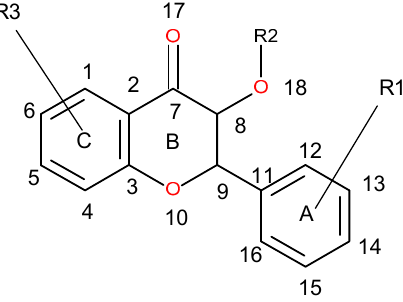
Figure 3. Basic skeleton of known Leishmania arginase inhibitors from the ChEMBL database. R1, R3